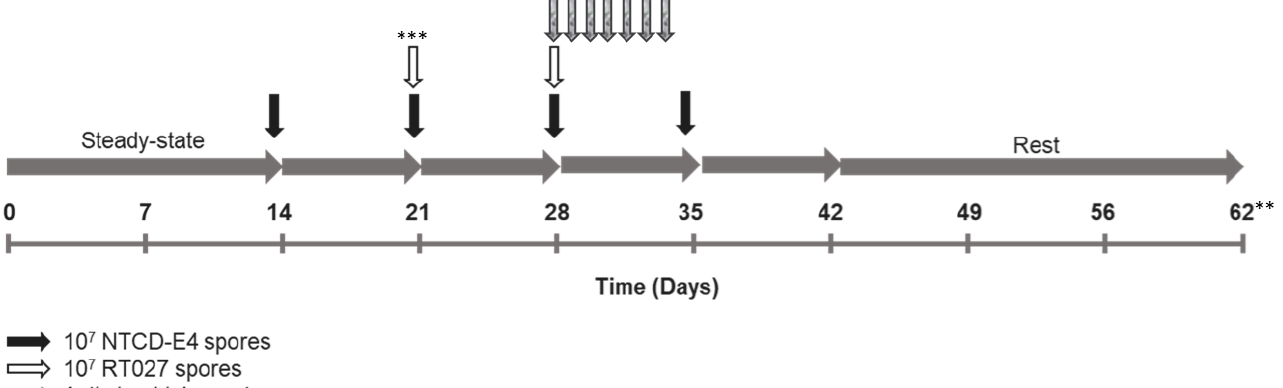
Figure 1. Experimental design for gut model studies evaluating non-toxigenic Clostridioides difficile (NTCD-E4) and C. difficile ribotype 027 (RT027). * Antimicrobial agents were evaluated individually over 7 days in competition C. difficile studies (gut models pre-inoculated with NTCD-E4) alongside controls of singly inoculated NTCD-E4 and RT027, with dosing regimens following standard clinical dosing (frequency and duration) at gut-reflective antimicrobial concentrations. DA, clindamycin 33.9 mg/L 6-hourly; CFX, cefotaxime 20 mg/L 12-hourly; CIP, ciprofloxacin 139 mg/L 12-hourly, AMP, ampicillin 8 mg/L 8-hourly [32–35]. ** CIP experiment was terminated after 56 days. *** In experiments with NTCD alone, an additional dose of NTCD-E4 spores was instilled on day 21 rather than RT027